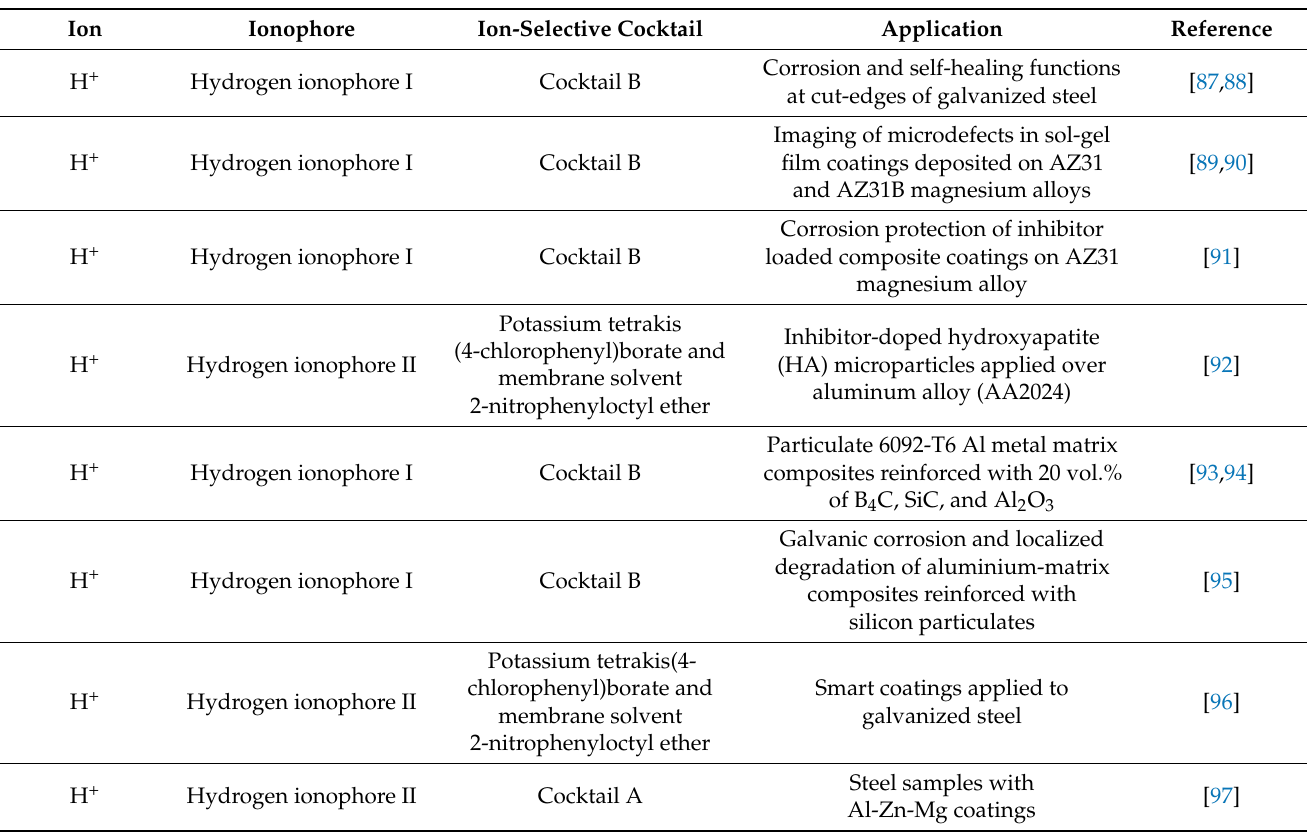
Table 4. Ion-selective microelectrodes (ISME) used as potentiometric probes in SECM characterization of thin surface layers and coatings on